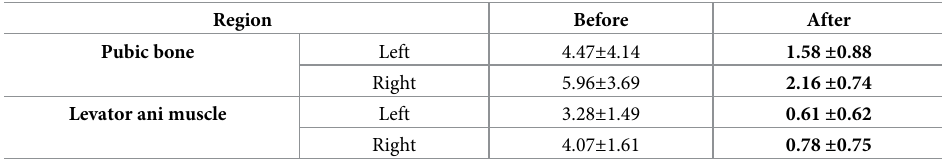
Table 3. Comparison of mean SDM on the registration